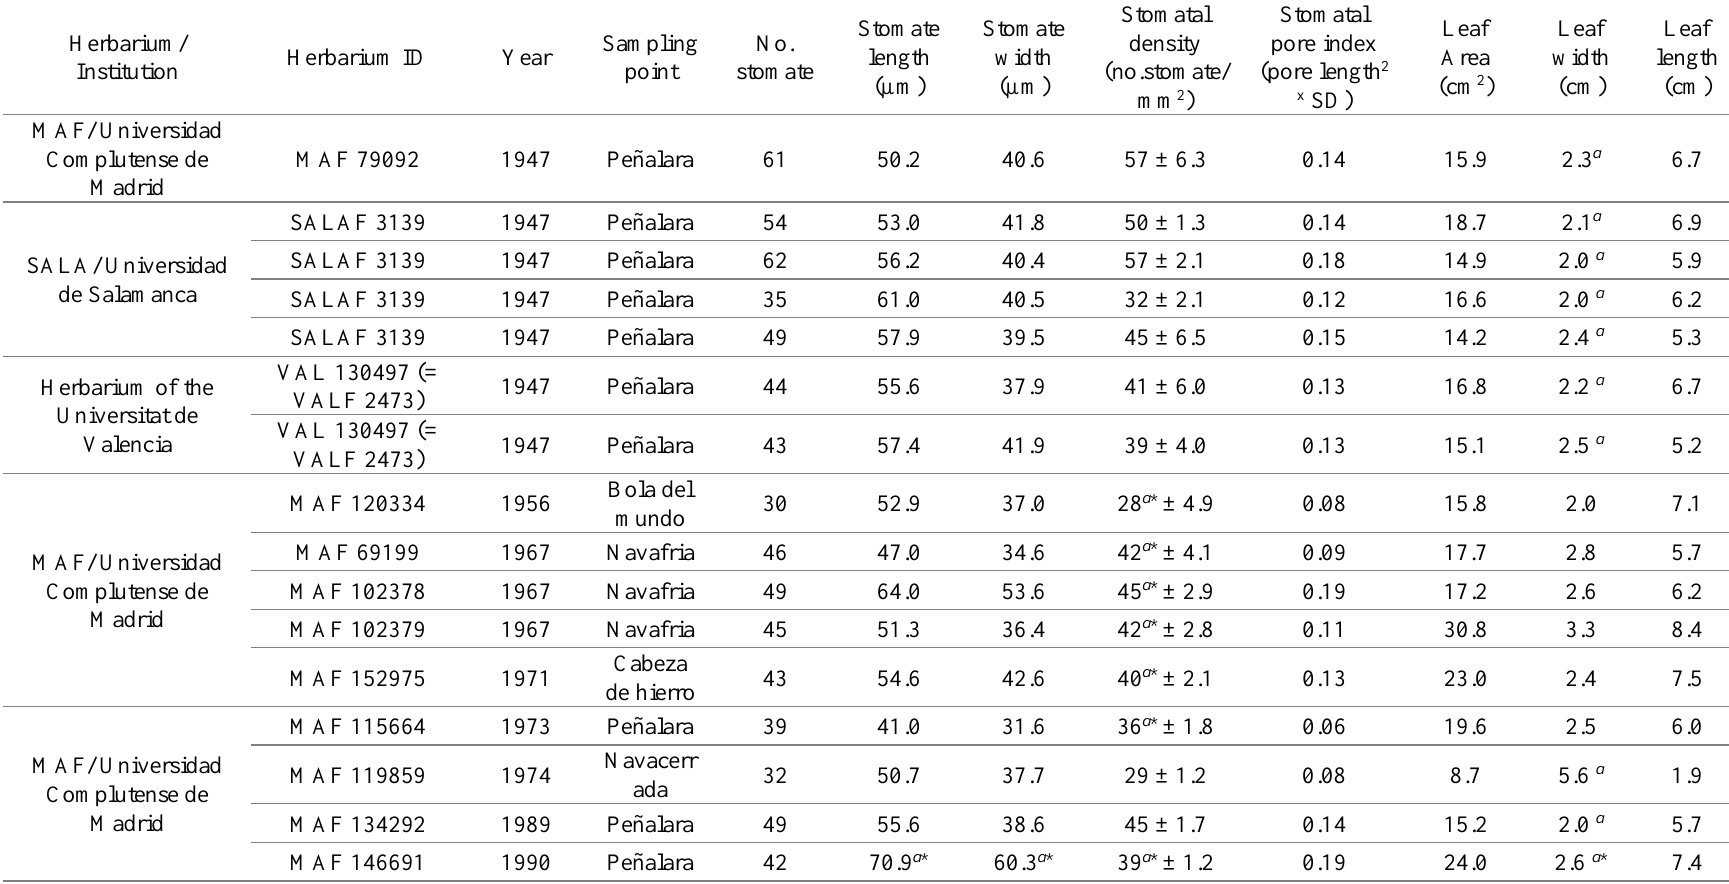
Table S2. Herbaria data of the studied S. carpetanus specimens selected for the present study, coupled with the mean morphological parameters measured per herbarium record. Herbaria data includes the respective location and information of each consulted sheet. Significant effects of summer temperature and summer rainfall are represented by asterisks and letters ( a ), respectively: *** and aaa , p value < 0.001; ** and aa , p value < 0.01 ; * and a , p value < 0.05